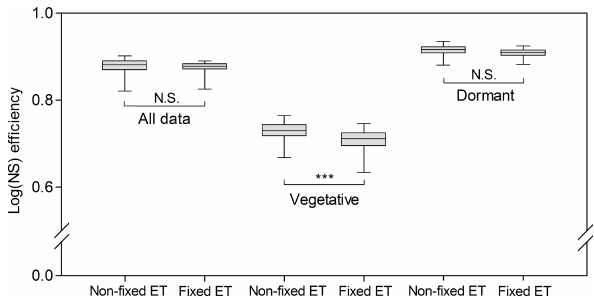
Figure 4. Box plot of the 100 best log(NS) efficiencies obtained with the Monte Carlo (MC) simulations using the model configura- tion that included the riparian compartment at the downstream site. MC analyses were performed using first all potentially sensitive parameters (non-fixed ET), and second fixing evapotranspiration- related parameters (fixed ET), for all data, and for the vegetative and dormant periods separately. Means of corresponding distribu- tion pairs were compared using Tukey’s honestly significant differ- ence tests. “N.S.” indicates no significant difference and ∗∗∗ indi- cates a statistically significant difference ( p < 0 .